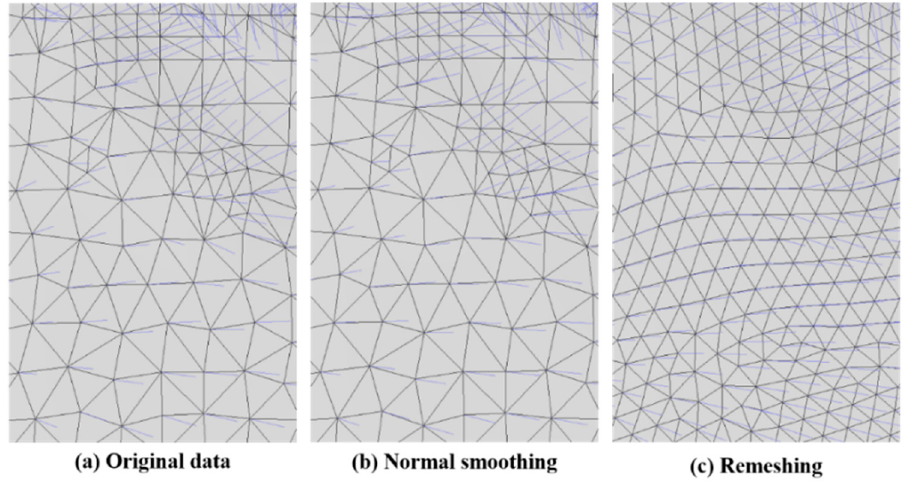
Figure 4. Results of normal correction methods for scan data. ( a ) raw scan data, ( b ) normal smoothing, ( c ) remeshing.